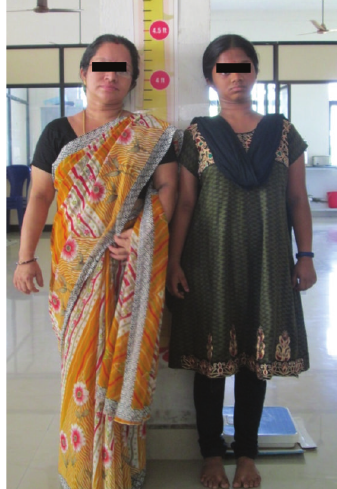
Figure 4: Extraoral